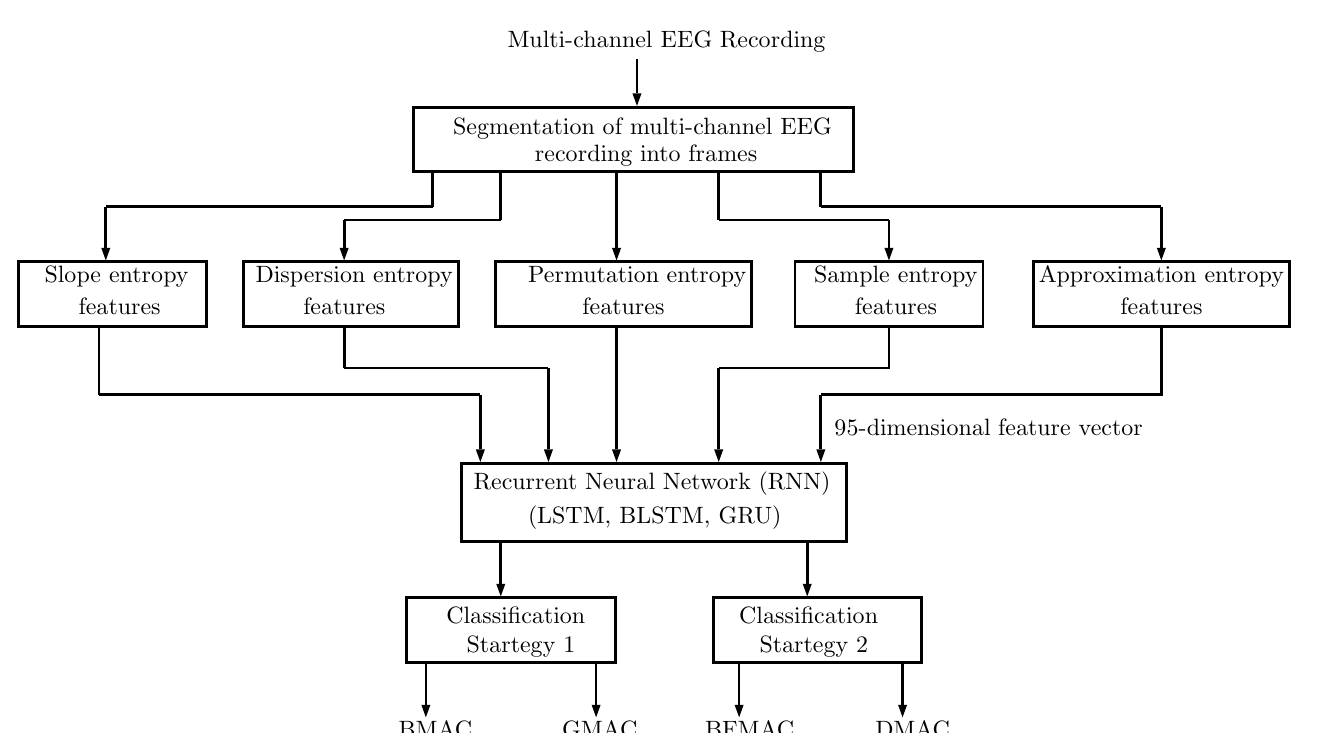
Figure 2. Flowchart of the proposed approach for the automated classification of mental arithmetic